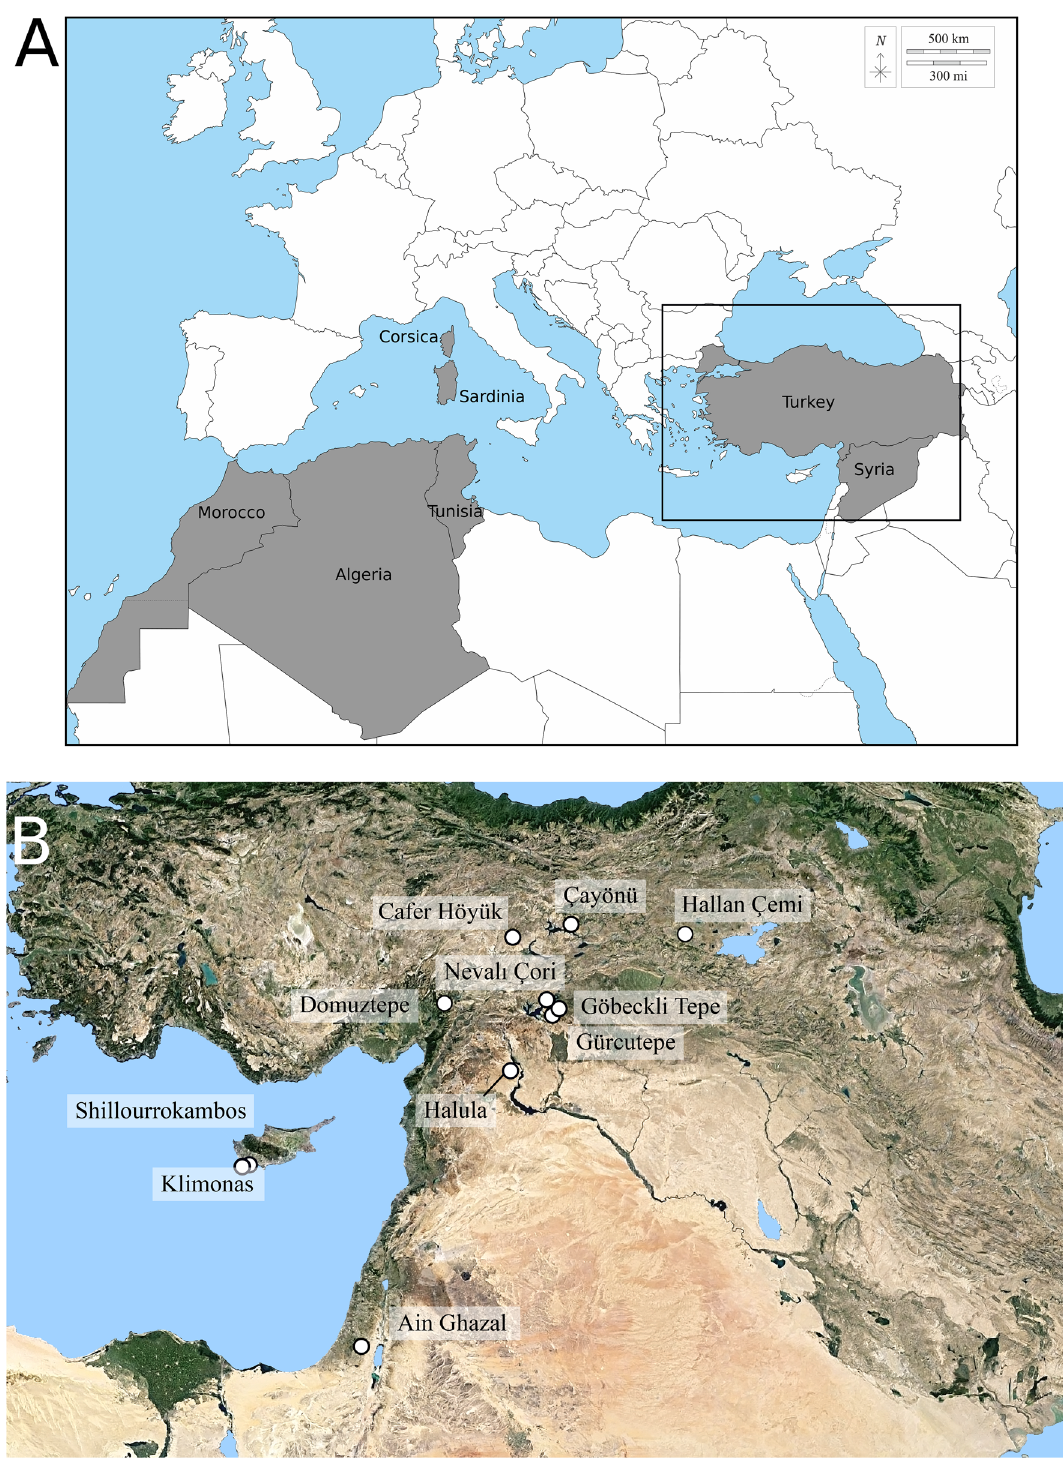
Figure 1. (A) Geographic provenance of the extant wild boars samples. (B) Localization of the PPN sites with Sus scrofa samples. Maps adapted from D-map (https://d- maps. com) by T. Cucchi and D.G. Kuriyama. Figure generated by TC with Inkscape